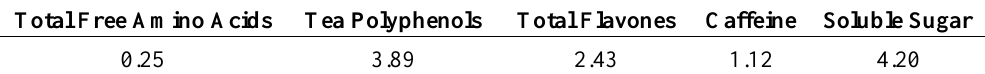
Table 2. Concentrations of main components of Fuzhuan brick-tea extract (g/100